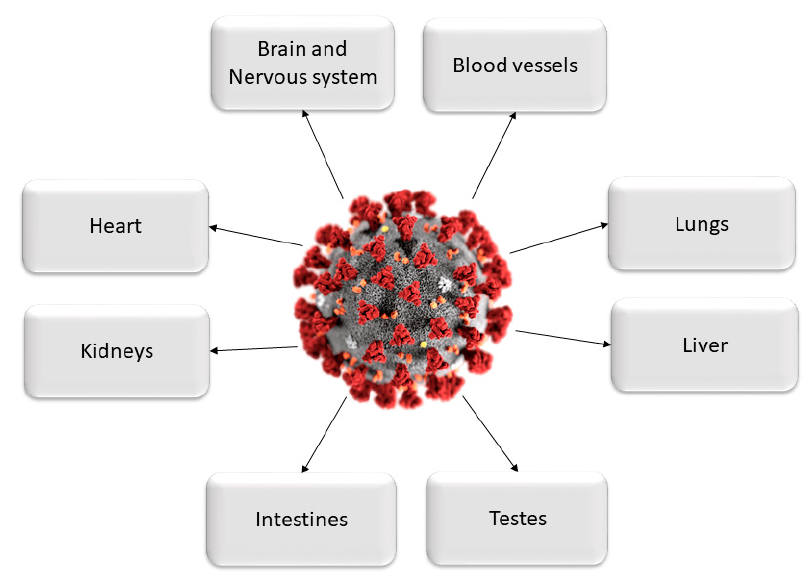
Figure 1. Major organs are affected by the damaging effects of COVID-19 infection.